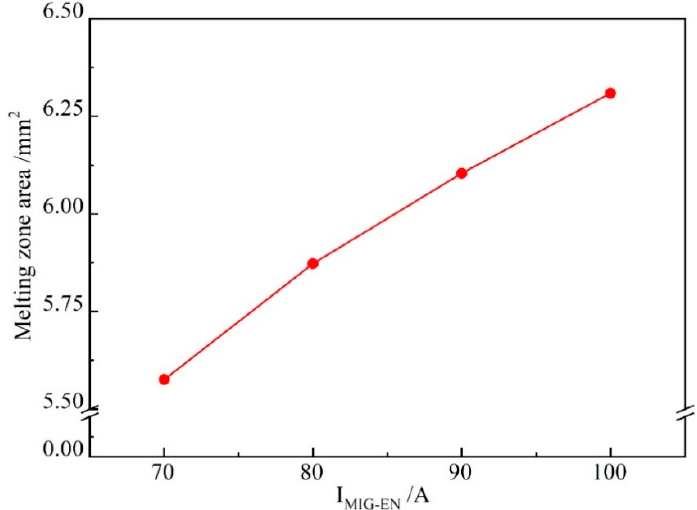
Figure 17. The melting area of the base metal for increasing I MIG-EN.